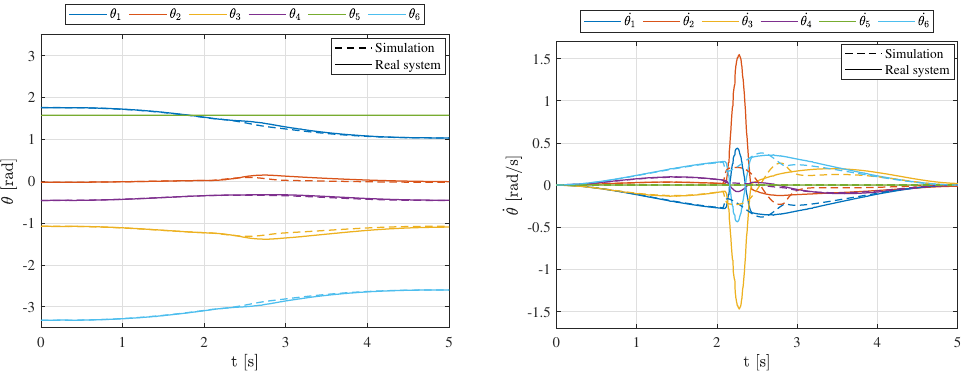
Figure 10. Test case 2, Mode III. Joint rotations ( left ) and speeds ( right